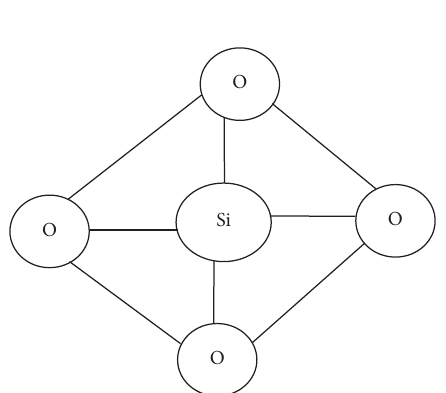
Figure 5: Structure of rice husk ash.